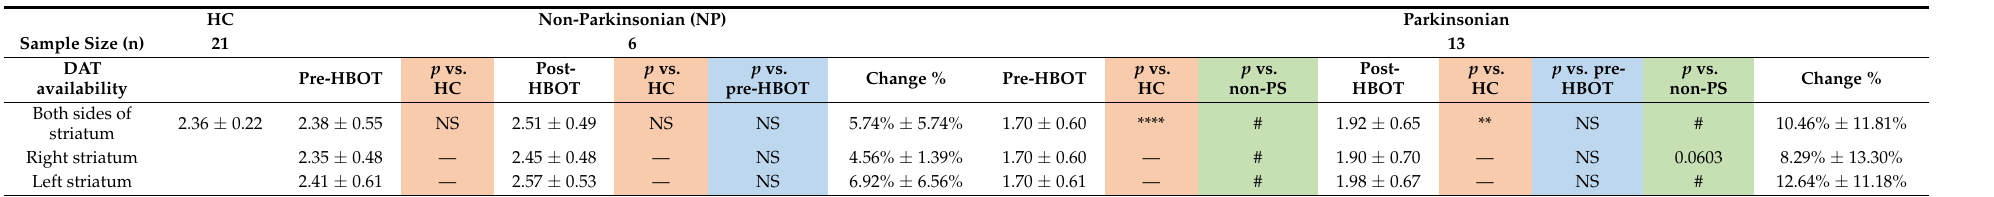
Table 3. Comparison of the 99mTc-TRODAT-1 DAT SPECT assessments of patients with non-Parkinsonian syndrome (NP) and Parkinsonian syndrome exposed to carbon monoxide poisoning and healthy control (HC)